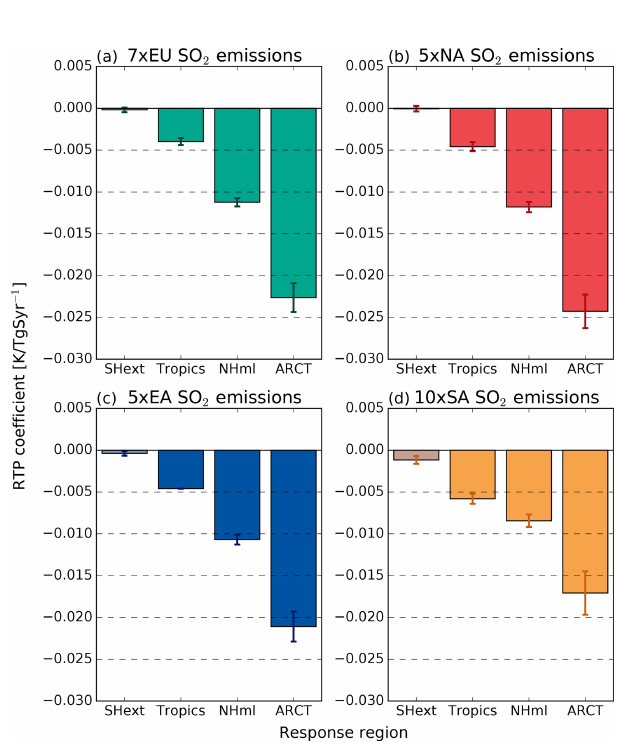
Figure 4. Latitudinal RTP coefficients for SO 2 emission K(TgSyr − 1 ) − 1 for (a) EU emissions, (b) NA emissions, (c) EA emissions and (d) SA emissions. Grey shading indicates that the temperature change is not statistically significant ( p > 0 . 05) com- pared to the control simulation. The error bars show the standard